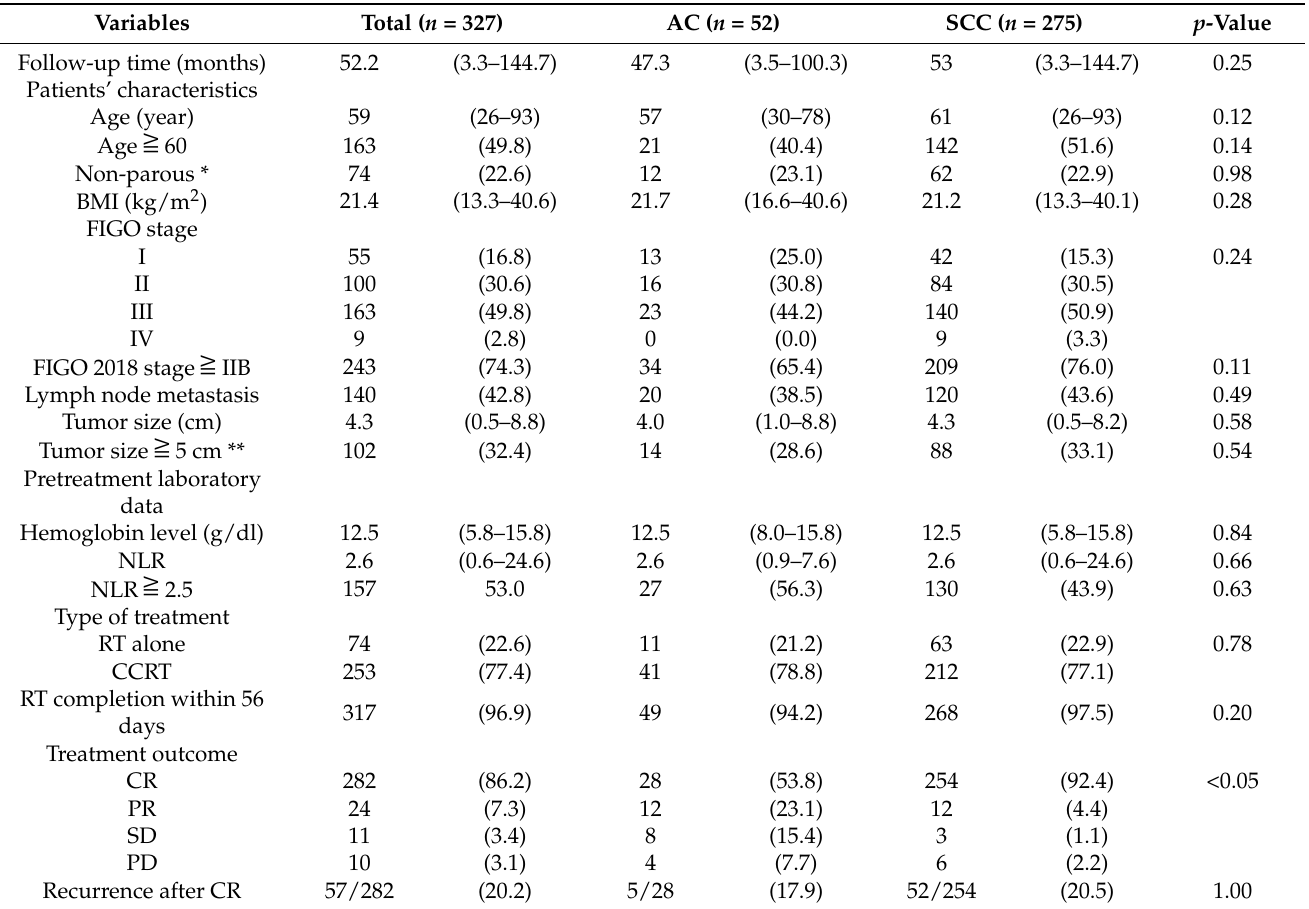
*Adjusted for FIGO stage, histology, tumor size, and NLR. ** Three patients had missing data.